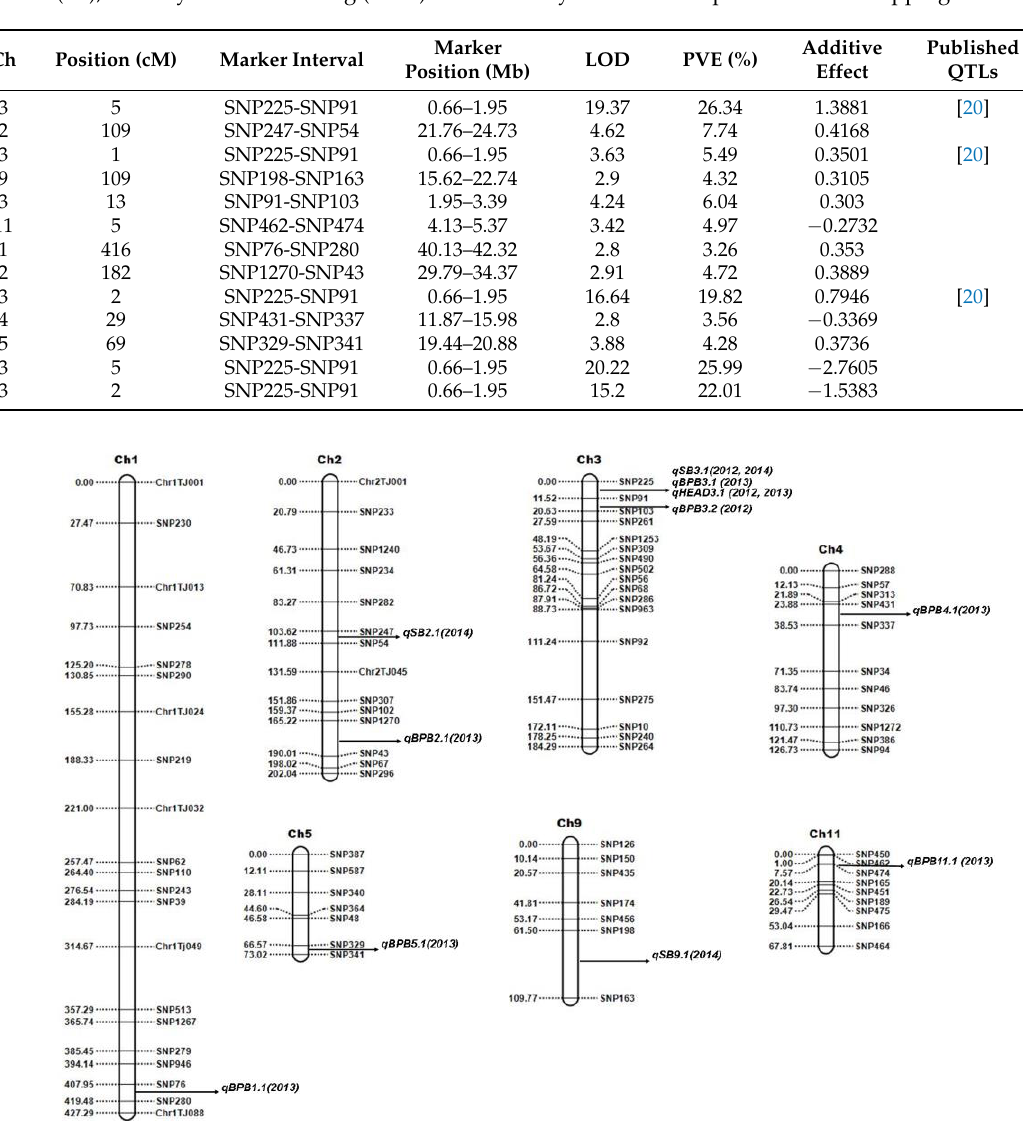
Table 3. Additive QTLs detected for the traits related to bacterial panicle blight (BPB), sheath blight (SB), and days to 50% heading (DTH) in the RILs by inclusive composite interval mapping.